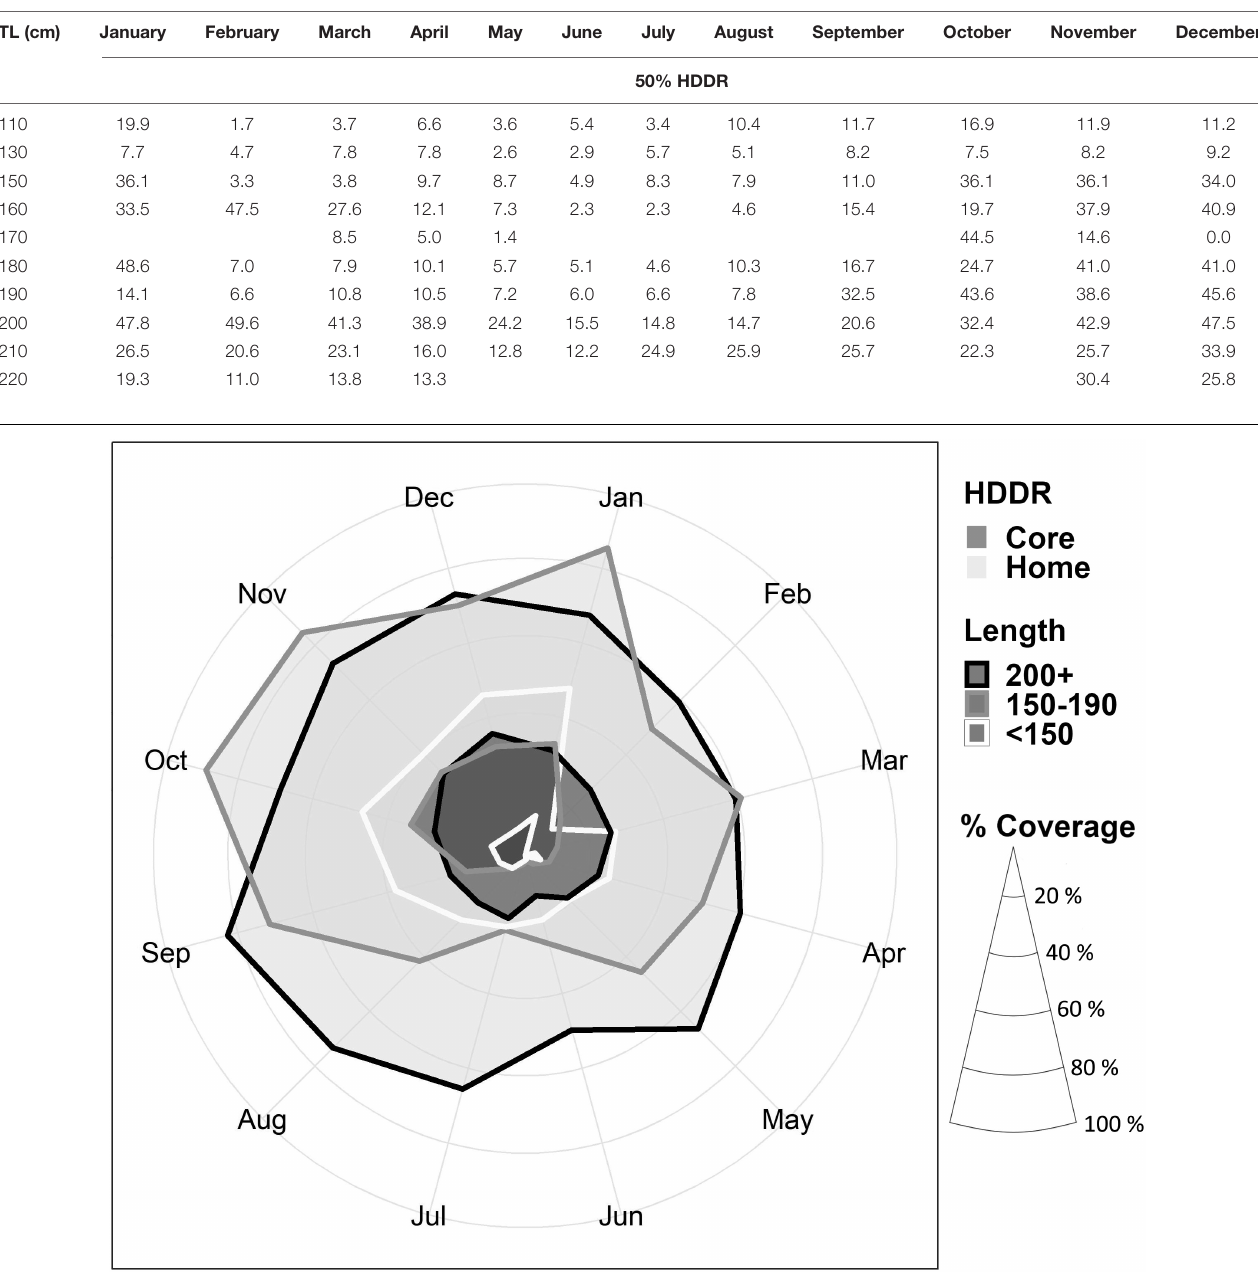
TABLE 3 | The percentage area of the LStSoJ MPA (717 km 2 ) that matches the core (50%) highest density depth regions (HDDRs) for each 10 cm TL class per month. TL (cm)